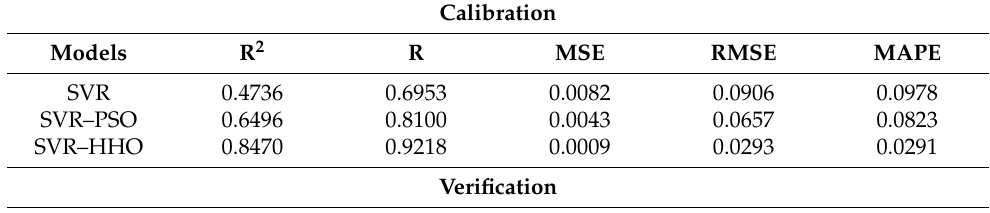
Table 10. Findings of the appraisal of the single and hybrid models for predicting GRG.